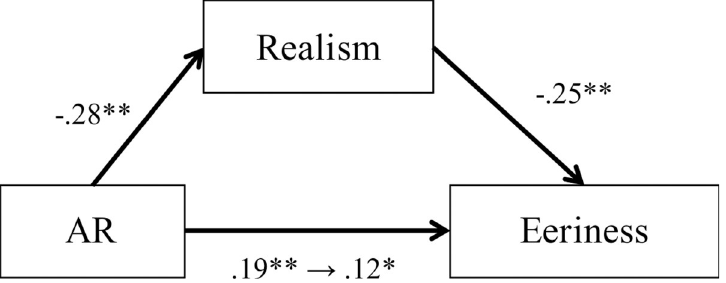
Fig 8. The results of the mediation analysis in Study 6. AR refers to animal-reminder disgust sensitivity. The numerical values around the arrows indicate standardized partial regression coefficients. An indirect effect is significant. � p < .05, � p <